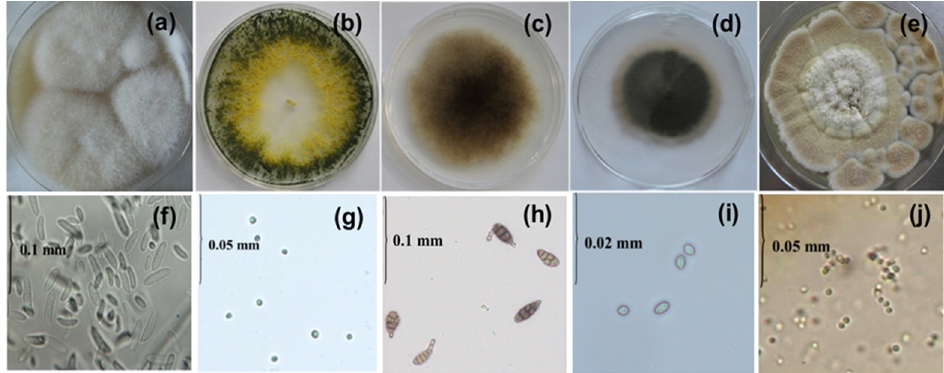
Figure 1. Photographs of spore-bearing colonies on agar medium ( a – e ) and spores (conidia) under a microscope ( f – j ): ( a , f ) Fusarium solani ; ( b , g ) Trichoderma harzianum ; ( c , h ) Alternaria alternata ; ( d , i ) Cladosporium cladosporioides ; ( e , j ) Aspergillus terreus.